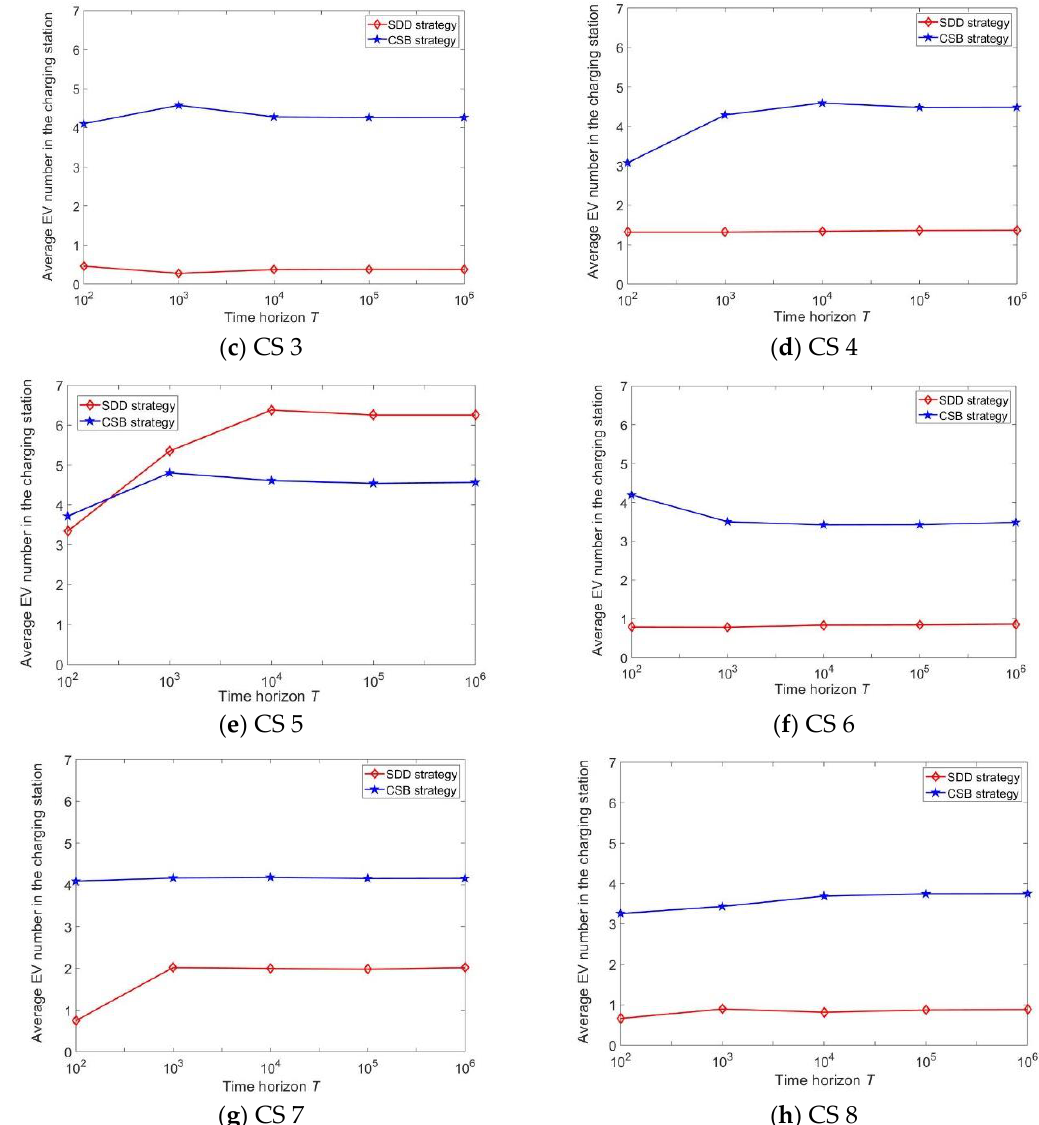
Figure 6. Average electric vehicle (EV) number at each charging station during different time horizons T .